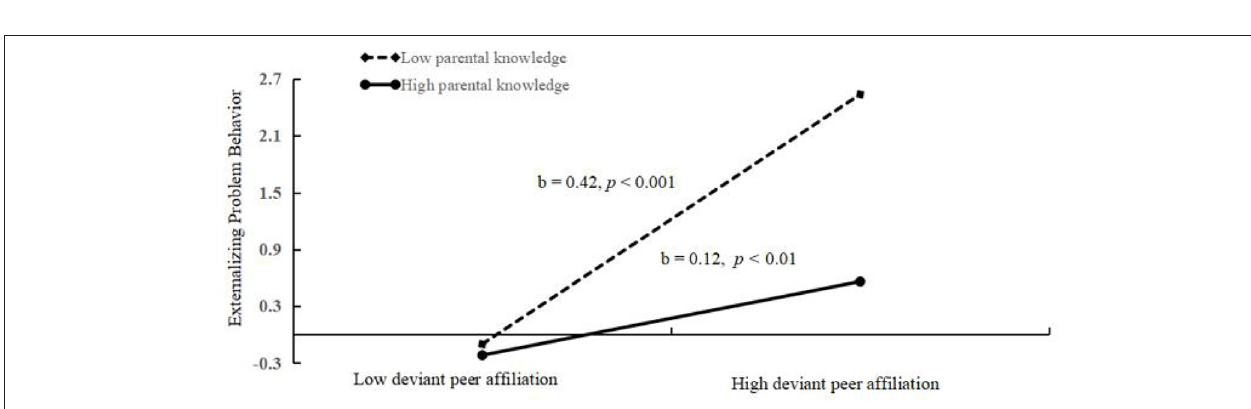
FIGURE 6 | Test of the moderating effect of parental knowledge on the indirect association between community violence exposure and externalizing problem behaviors. *** p < 0.001, ** p < 0.01.